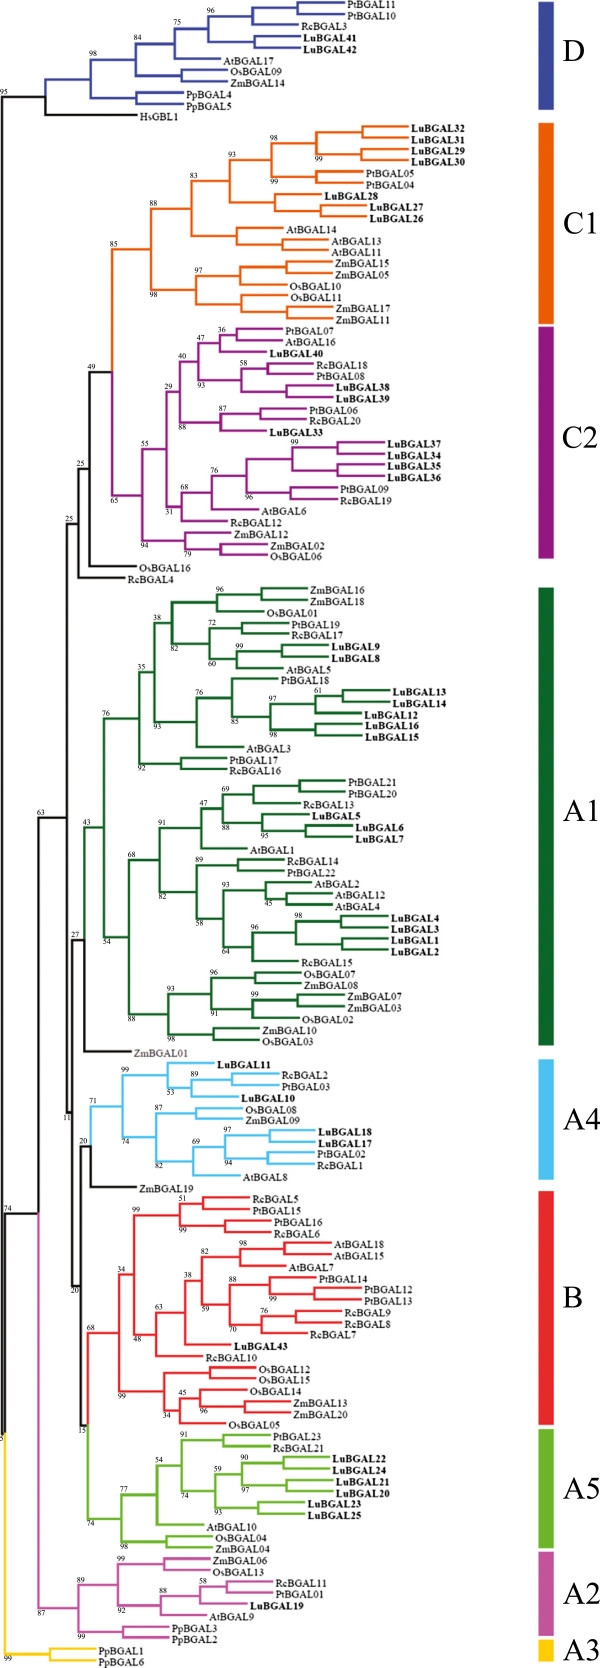
Phylogenetic relationship among the glycosyl hydrolase 35 proteins of flax other species. Deduced amino acid sequences were aligned with MUSCLE [25]. The tree was created with GARLI [28], using the maximum likelihood method, following the WAG model of amino acid substitutions [27]. A consensus tree of 1000 bootstrap replicates was produced for which percent reproducibility under 100 is shown. The flax sequences are named LuBGAL, and numbered according to Tables 1 and 2. Arabidopsis thaliana sequences are indicated as AtBGAL, and numbered according to existing designations [23]. Oryza sativa sequences are indicated as OsBGAL, and numbered according to existing designations [24]. Physcomitrella patens sequences are indicated as PpBGAL, Populus trichocarpa sequences are indicated as PtBGAL, and Ricinus communis sequences are indicated as RcBGAL. Genomic loci corresponding to these sequences are presented in Table 1. A human beta-galactosidase (GLB1; NP_000395) was used to establish the outgroup.